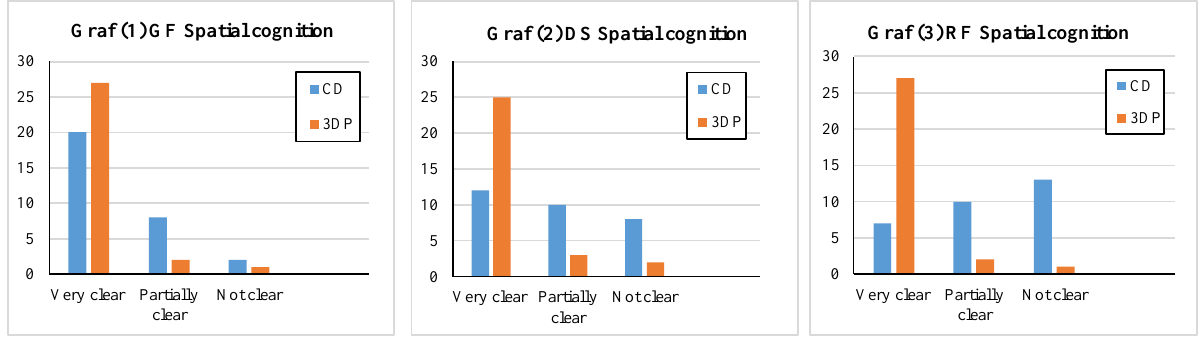
Figure 5. Descriptive results of the CD and 3DP spatial